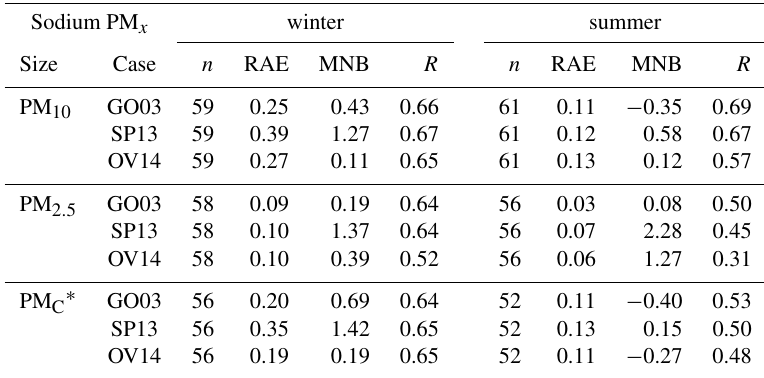
Figure 12. Similar to Fig. 11 but showing data for Westerland. No sodium PM 2 . 5 data were available and no sodium PM C concentrations were calculated. Table 4. Similar to Table 3 but for the Melpitz station only and for different particle